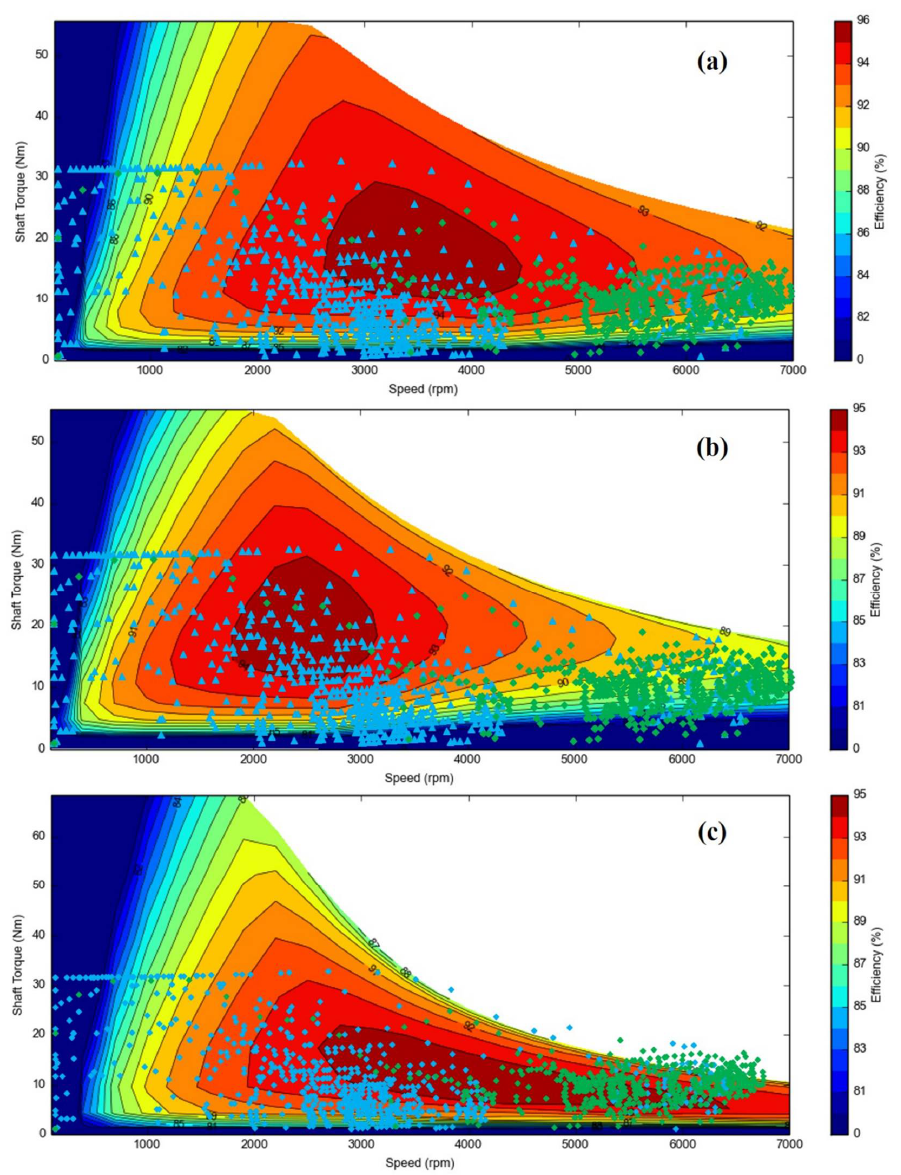
Figure 15. Efficiency map of IPMSMs and PMa-SynRM over the driving cycles: ( a ) double layers magnet IPMSM, ( b ) v-shaped magnets IPMSM, and ( c ) PMa-SynRM.